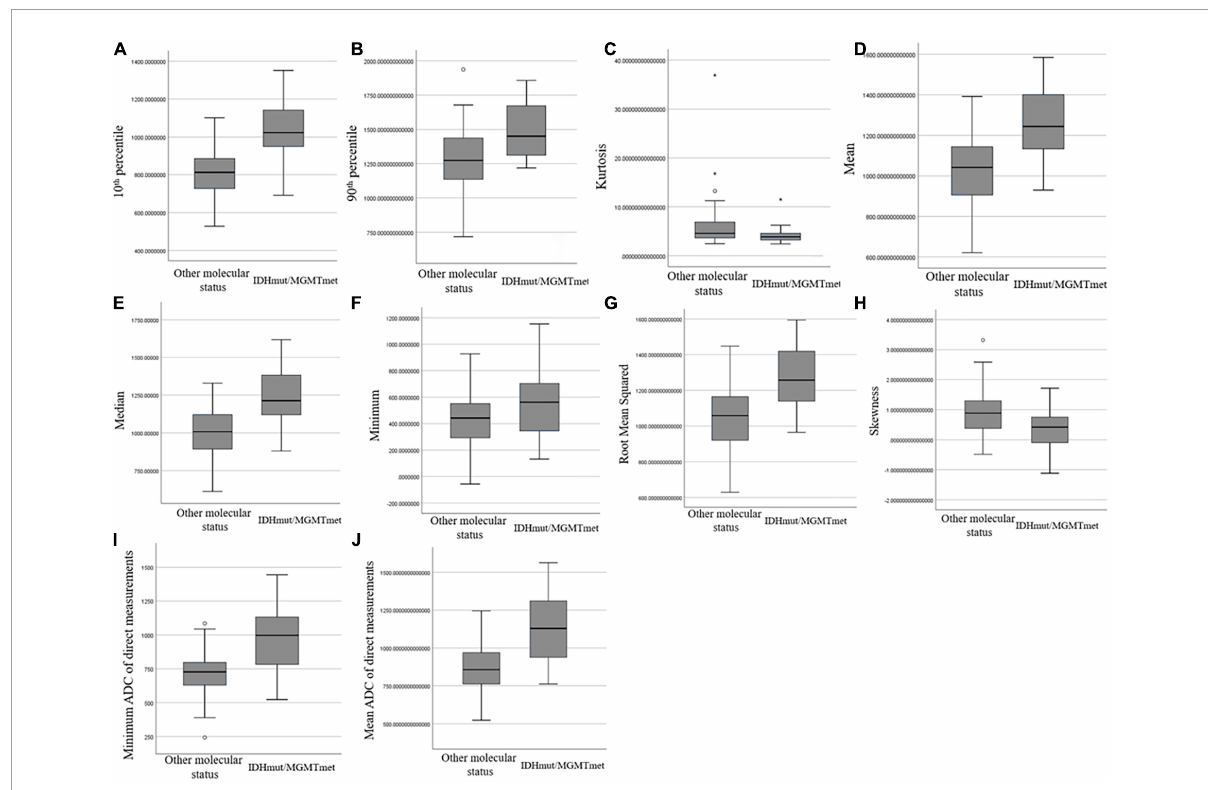
FIGURE3 Box and whisker plot graphs showing comparison of ADC histogram parameters that were statistically different (A–H) and minimum ADC (I) and mean ADC (J) of direct measurements between IDHmut/MGMTmet and the other glioma